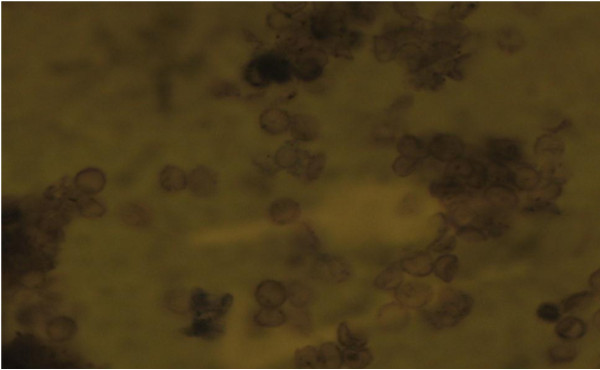
Picture of sickle cell patient blood treated with Vernonia amygdalina (Magnification: x1000).